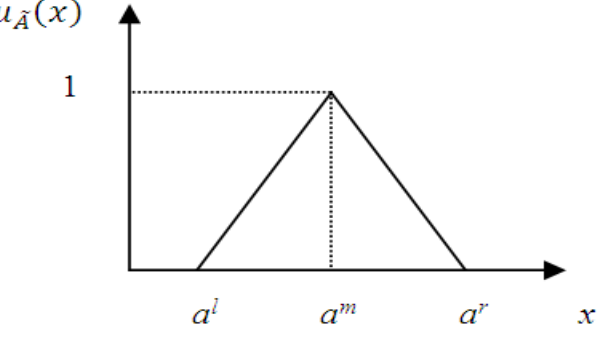
Fig. 2. Triangular fuzzy number (Zadeh, 1965,